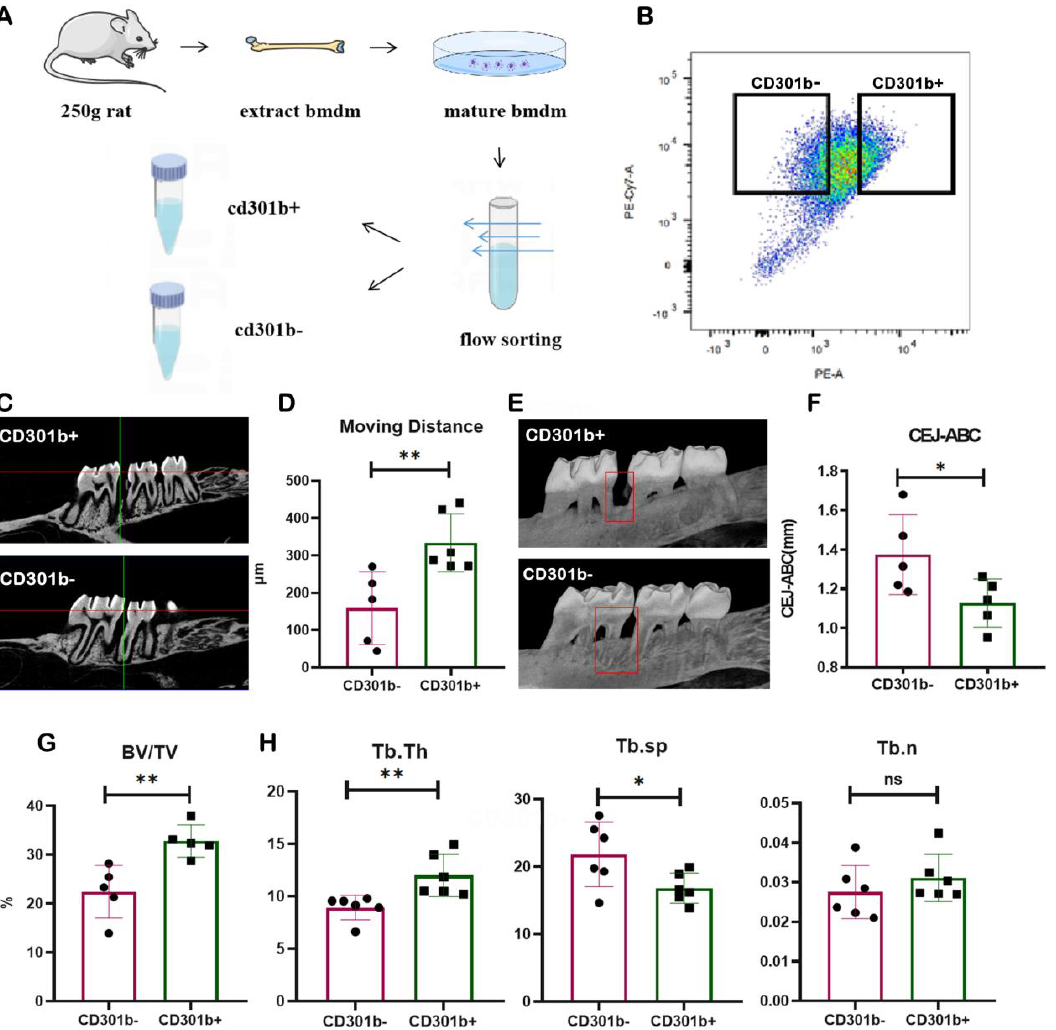
Figure 5. The return infusion of CD301b+ cells into the subgingival area of orthodontically mobile teeth can promote orthodontic tooth movement efficiency and improve the periodontal microenvi- ronment: ( A ) schematic diagram of the sorted cells as well as the reinfused cells; ( B ) gating strategy diagram of cell sorting; ( C ) micro − CT image of the alveolar bone; ( D ) tooth movement distances of CD301b − and CD301b+ macrophage groups; ( E ) micro − CT image of bone resorption; ( F ) CEJ − ABC; ( G ) BV/TV; ( H ) parameters of each bone trabeculae. Values are presented as means ± SD. Note: * p < 0.05, ** p < 0.01, ns = no significance; n = 5 −6; bar = 100 μm .